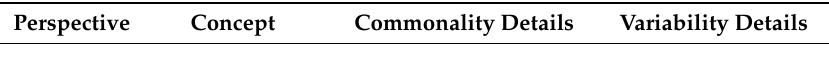
Table 1. The domain analysis